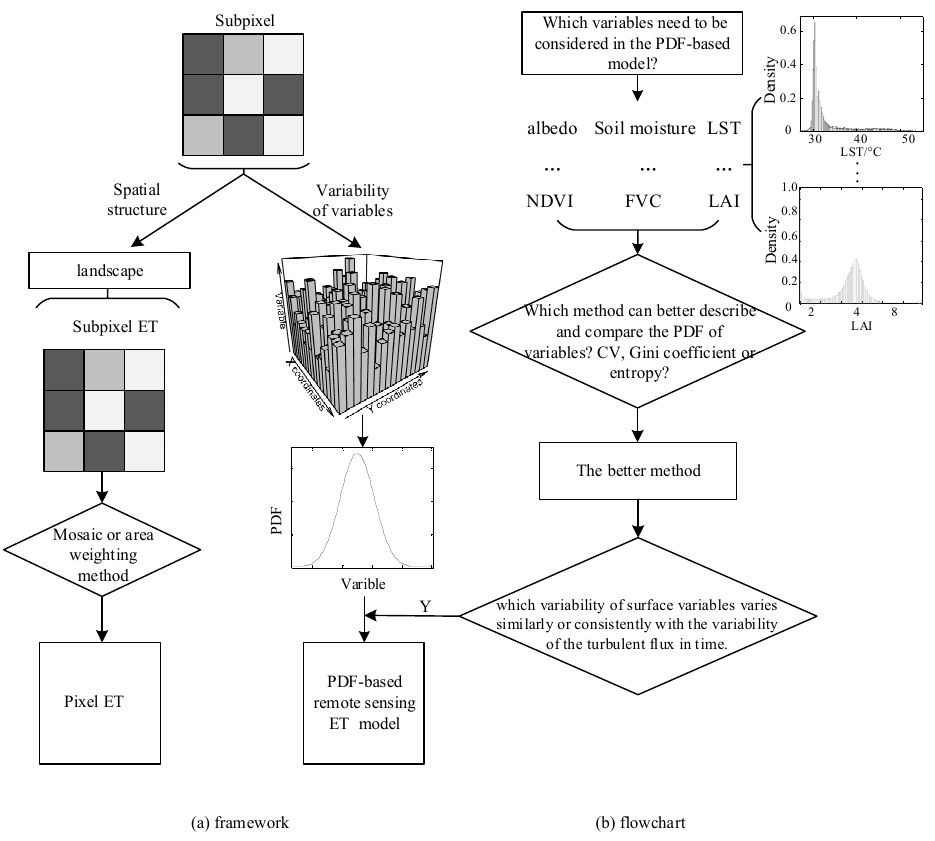
Figure 2. Framework and flowchart of this paper.